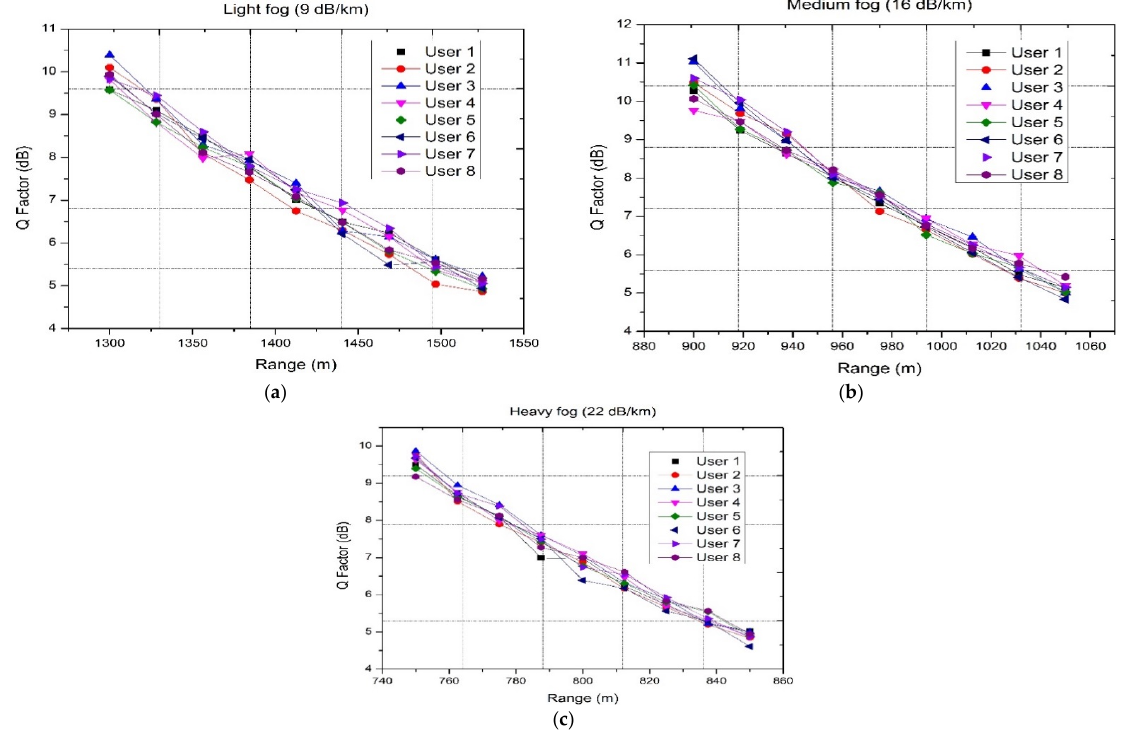
Figure 7. Q-factor of FSO-PDM/PV-OCDMA system versus FSO link under ( a ) LF, ( b ) MF, and ( c ) HF.